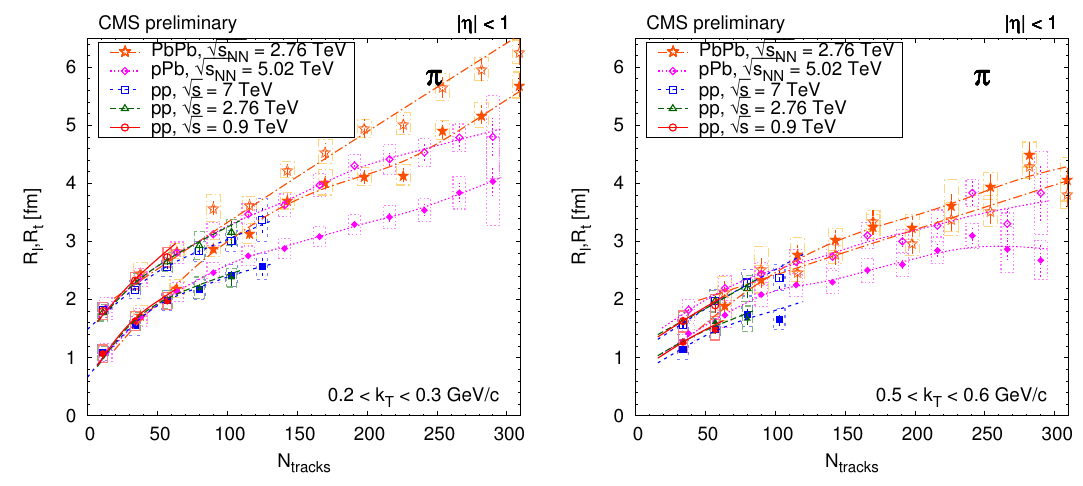
Figure 6. The N tracks dependence of the two-dimensional pion radii ( R l —open symbols, R t —closed symbols), shown here for several k T bins, for all studied reactions [8]. Lines are drawn to guide the